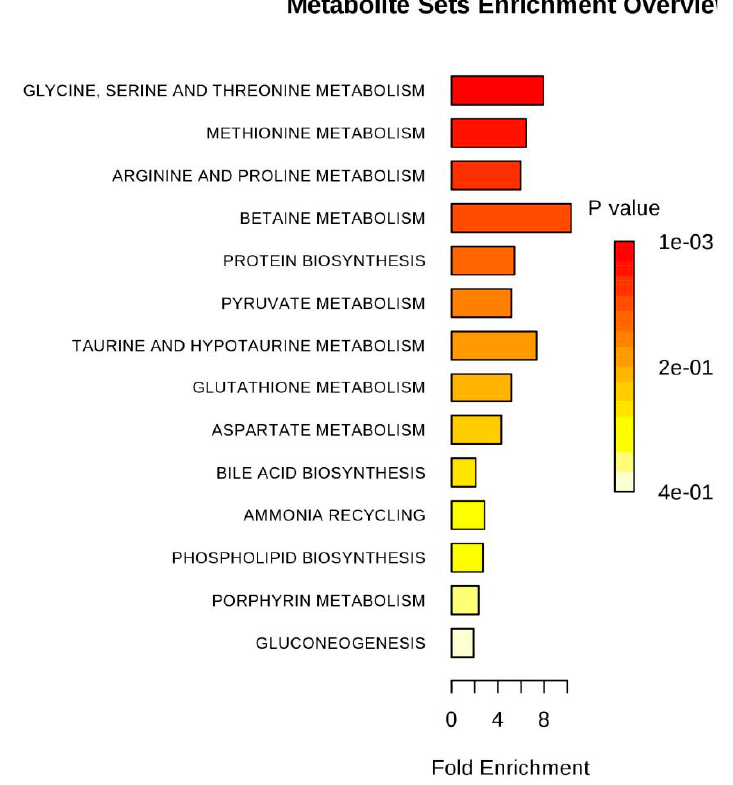
Figure 12. Pathway enrichment of di ff erences metabolites between SPPM60-Dand control groups.